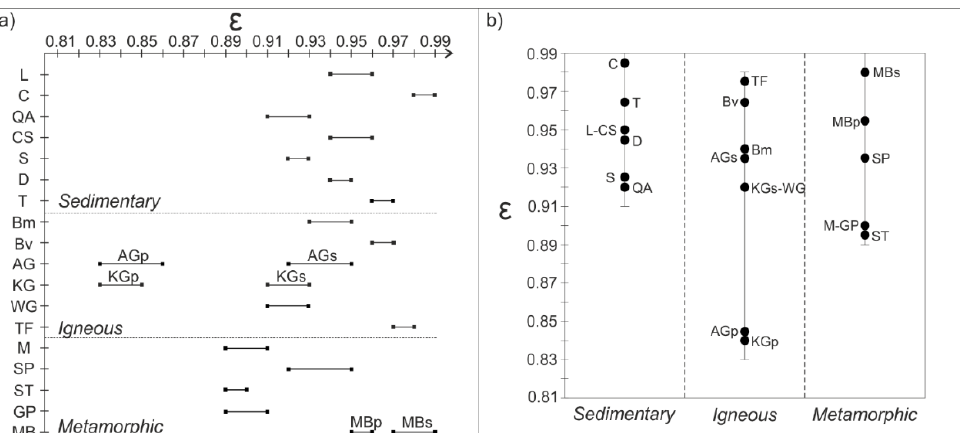
Figure 4. ( a ) Emissivity ranges resulting for each tested rock type; ( b ) statistical plot of the emissivity ranges for the three sedimentary, igneous, and metamorphic rock groups. Whiskers represent maximum and minimum values, while dots indicate the average emissivity for each rock type (acronyms are listed in Table 2).